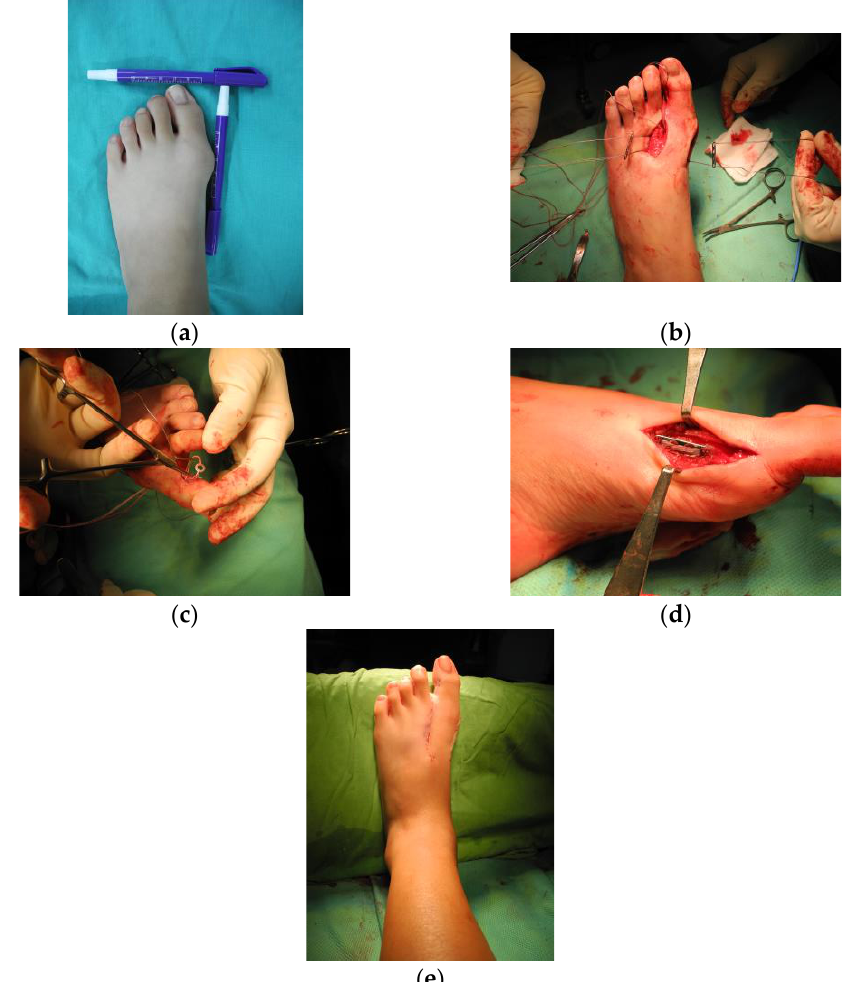
Figure 2. Surgical photos showing some steps in the transosseous suturing technique. ( a ) Preoperative general appearance of the hallux valgus. ( b ) Mini plates applied at the first and second metatarsals through the wire. ( c ) Medial capsuloligamentous augmentation for anchoring Fiberwire with the washer. ( d ) Lateral view of the final position of the mini plate parallel to the metatarsal. ( e ) Postoperative general appearance after the correction of hallux valgus.